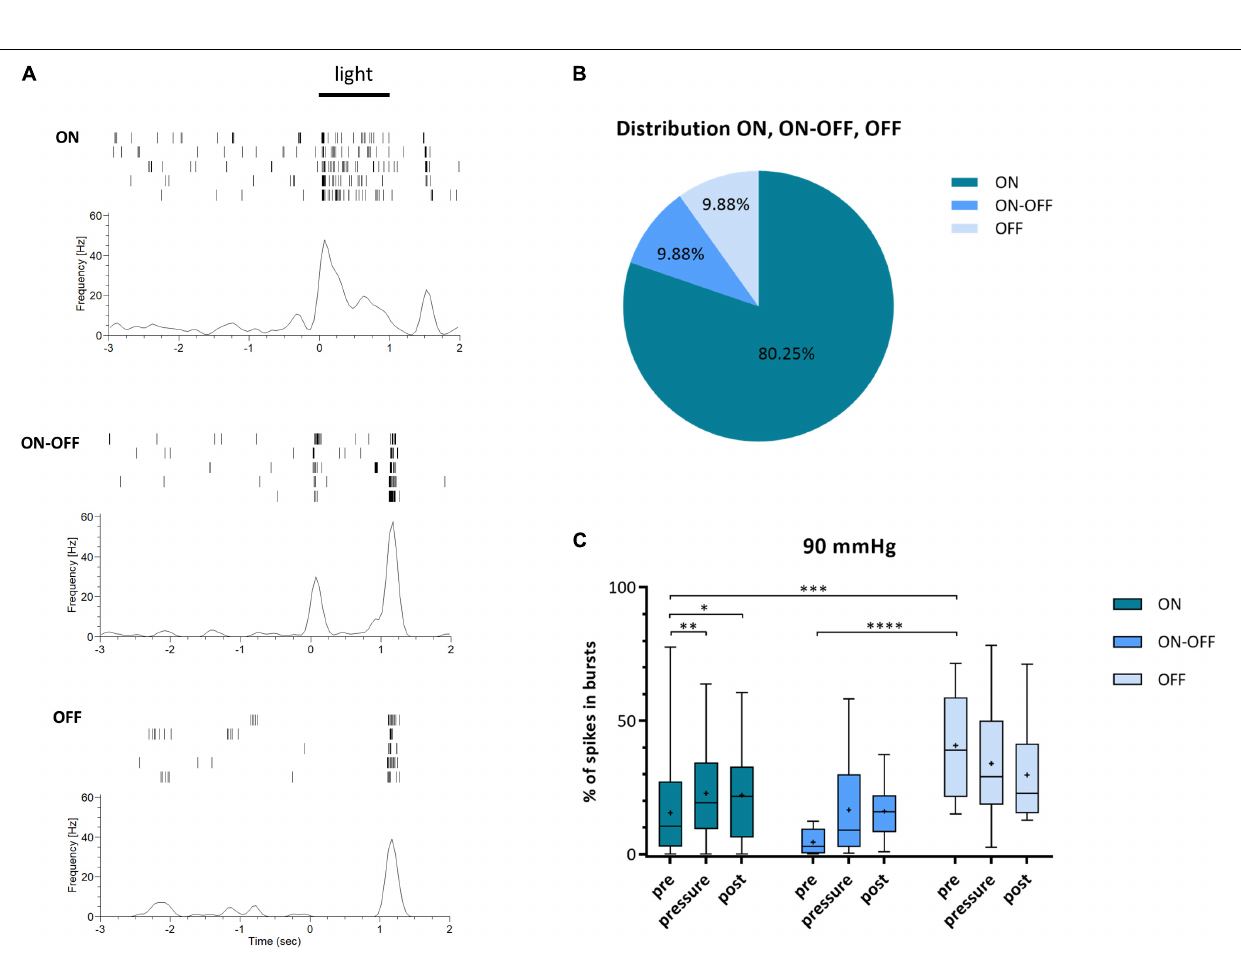
FIGURE 6 | Classification of RGCs into ON, ON-OFF, and OFF cells and their type specific bursting behavior under 90 mmHg. RGCs were categorized according to their response to light stimulation into the three categories ON, ON-OFF, and OFF. (A) Characteristic examples of ON-, ON-OFF-, and OFF responses of RGCs after light stimulation (full-field, 1 s, 160 lm) are shown. (B) The distribution of the three RGC categories ON (dark blue), ON-OFF (blue), and OFF (light blue) is presented. Uncategorized cells are not included. (C) The number of spikes in bursts [%] before (pre), during (pressure), and after (post) pressure stress of 90 mmHg for ON (dark blue), ON-OFF (blue), and OFF (light blue) RGCs is shown. Data are presented as box and whisker (min to max) plot. Mean values are shown as + . Significant values are indicated by asterisks. Two-way ANOVA with post hoc Tukey’s test was performed with GraphPad Prism Software version 7. (C) F (4, 156) = 2.12, p = 0.0809. n retinae = 5, n cells =